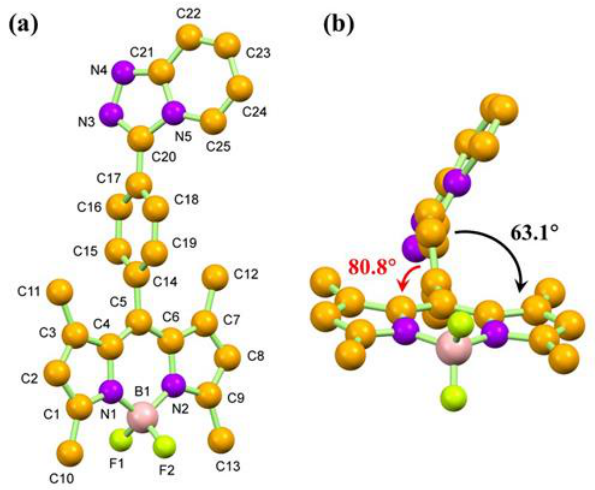
Figure 2. Molecular structures of compound 4 in top-view ( a ) and side-view ( b ). Non-IUPAC atomic numbering is used, and all the hydrogen atoms are omitted for simplification.